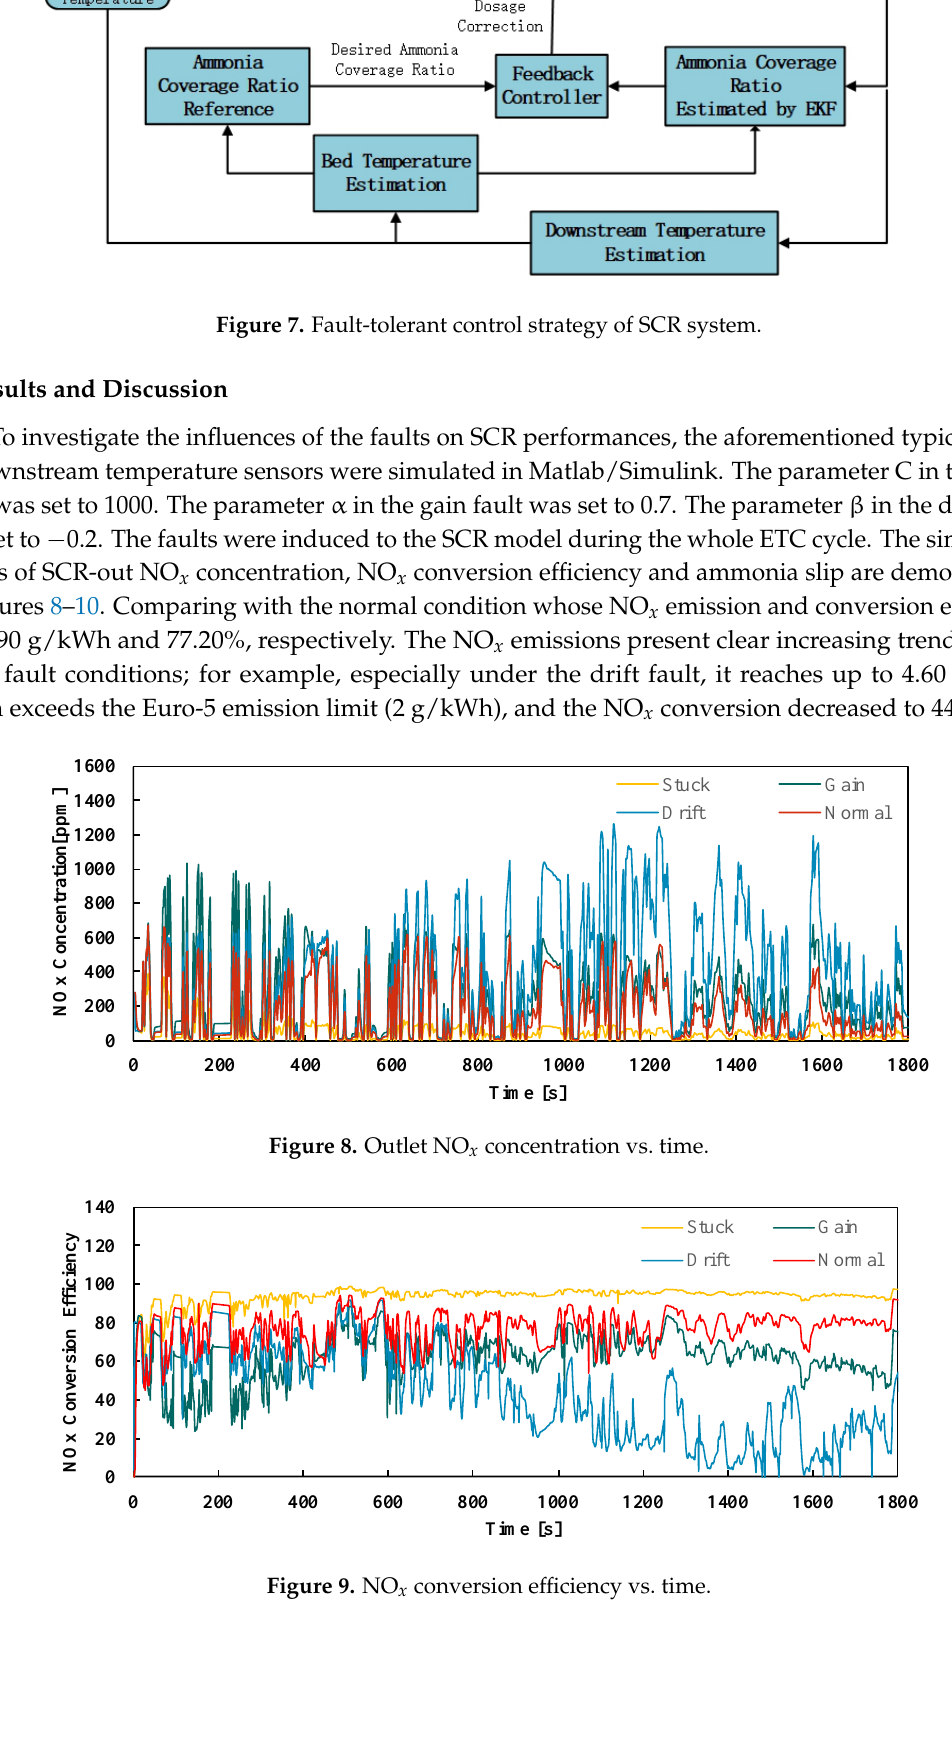
( b ) Figure 6. Comparison of simulation and experimental results. ( a ) Temperature vs. time; and ( b ) absolute error. Temperature sensor measurements will be compared with the estimates, and the temperature residuals R T can be expressed as: